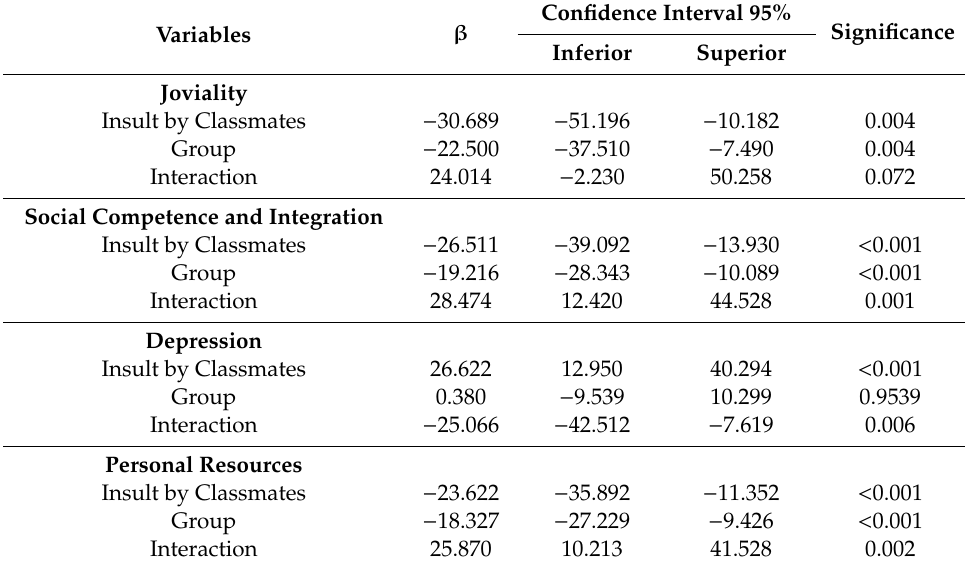
Table 8. Interaction of “Insult by Classmates” with Group on Joviality, Social Competence and Integration, Personal Resources, and Depression. FXS = Fragile X Syndrome. CG = control group (central tendency and variability).